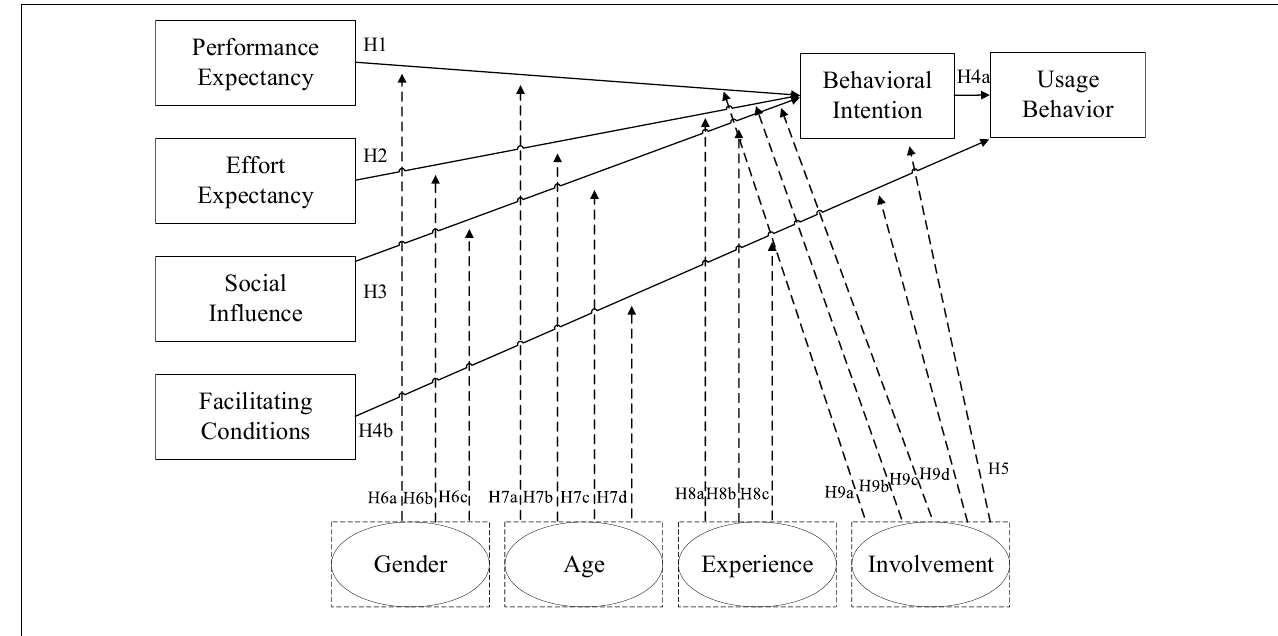
FIGURE 1 | Research